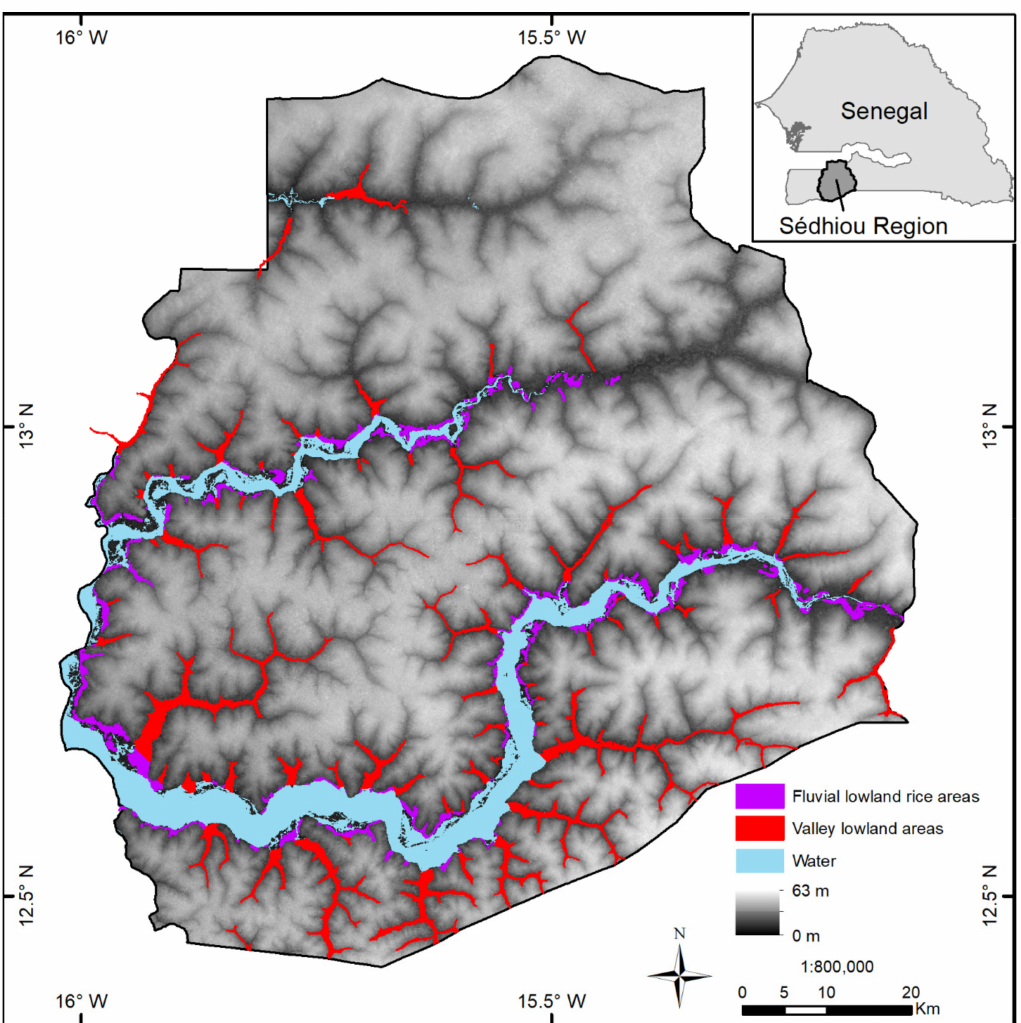
Figure 1. Study area and location of lowland rice areas in S é dhiou